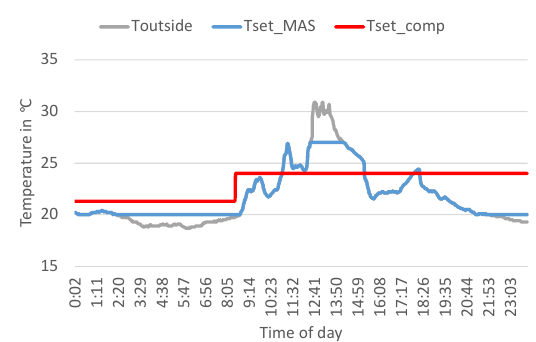
Figure 5. Set temperatures for user in MAS controlled and a comparison office.